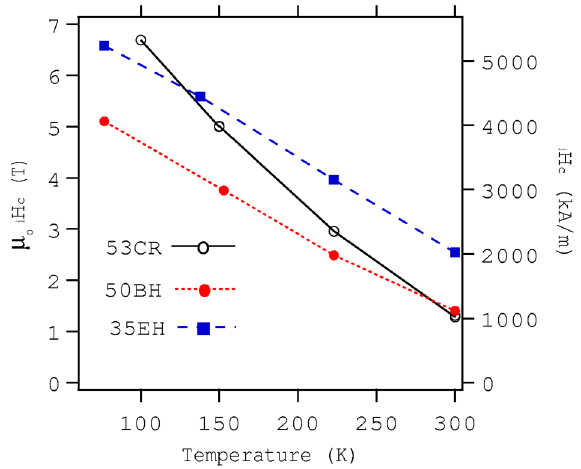
FIG. 3. (Color) Temperature dependence of the coercivity ( of sintered NdFeB magnets (35EH and 50 BH) and a PrFeB magnet